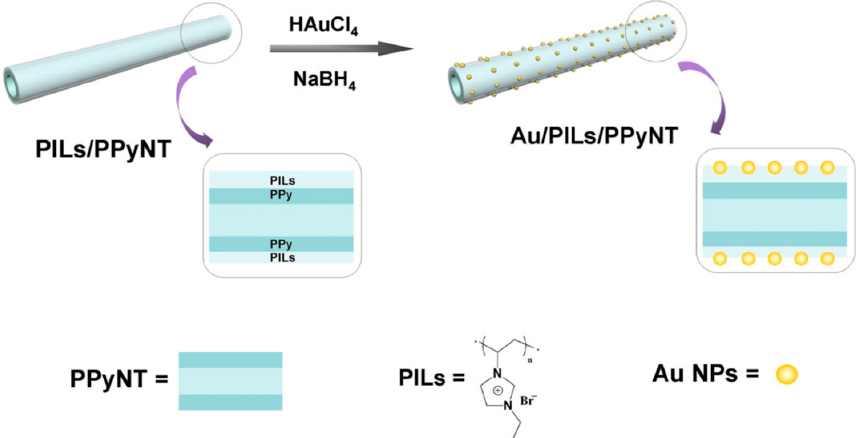
Figure 4. Reaction procedure for the preparation of polypyrrole nanotubes (PPyNTs)/poly(ionic liquids) (PILs)/gold nanoparticles (AuNPs). High-density and well-dispersed AuNPs could be deposited on the surface of PPyNTs/PILs by anion-exchange of PILs with Au precursor and the in situ reduction of the metal ions, due to the presence of PILs. Reprinted with permission from reference [70]. Copyright © 2017 Elsevier B.V.